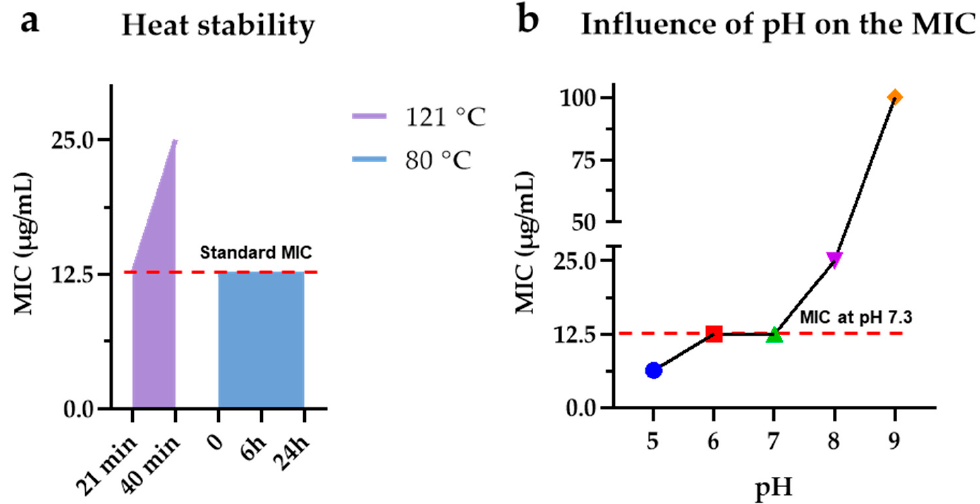
Figure 10. Stability of M15RL to high temperatures and influence of pH on the M15RL MIC. The mixture showed high resistance to high temperatures, being affected only after 40 min at 121 °C ( a ). On the other side, the antimicrobial activity of M15RL is highly affected by the pH of the environment, being less active at pH levels higher than 7 ( b ).